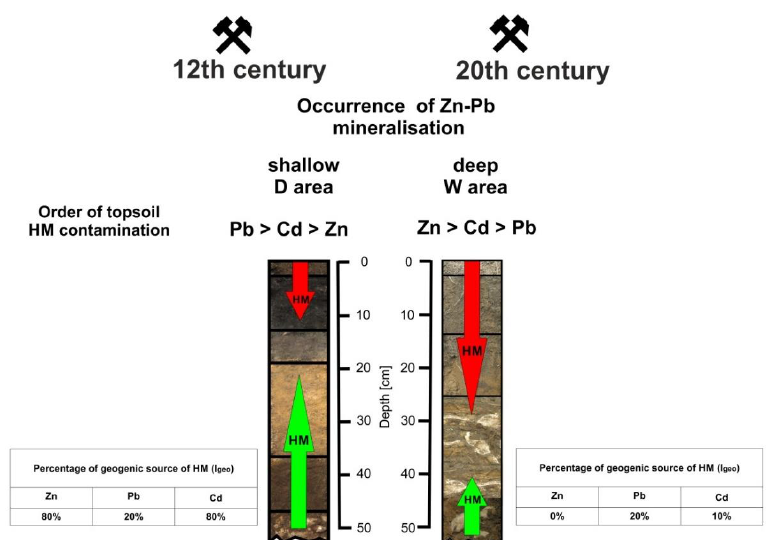
Figure 5. Graphical model of anthropogenic (red arrows) and geogenic (green arrows) HM immissions into the topsoil of the D-Dlugoszyn and W-Wilkoszyn areas.